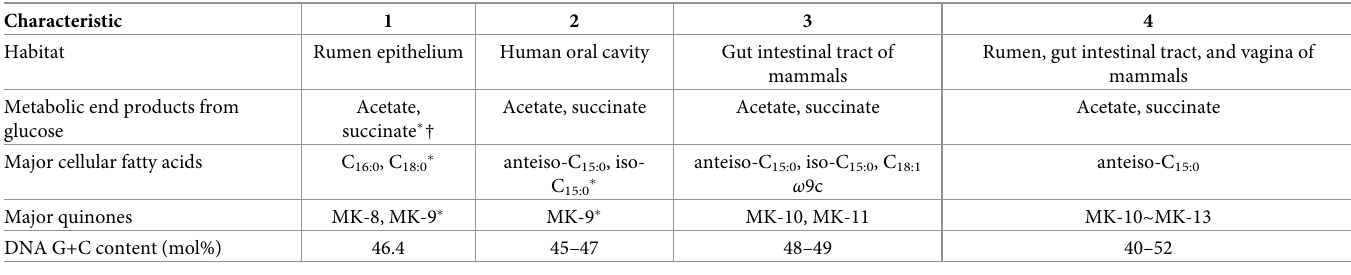
Table 3. Comparison of characteristics between Pseudoprevotella gen. nov. and closely related genera within the family Prevotellaceae . Characteristic